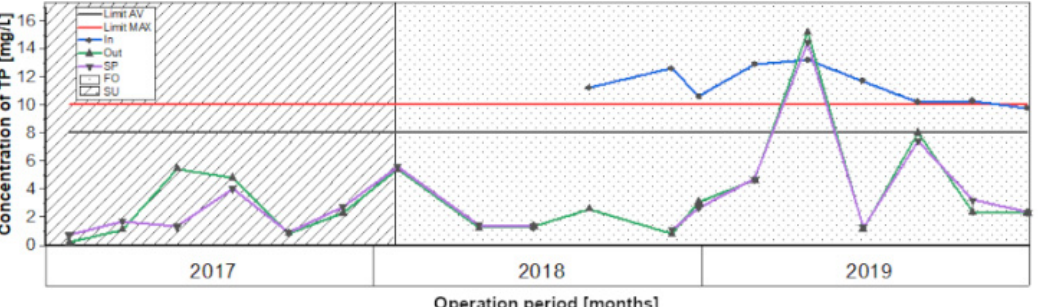
Figure 5. TP concentration development. AV = average limit, MAX = maximal limit, In = inlet, Out = outlet, SP = stabilization pond, FO = full operation, SU = start-up phase.